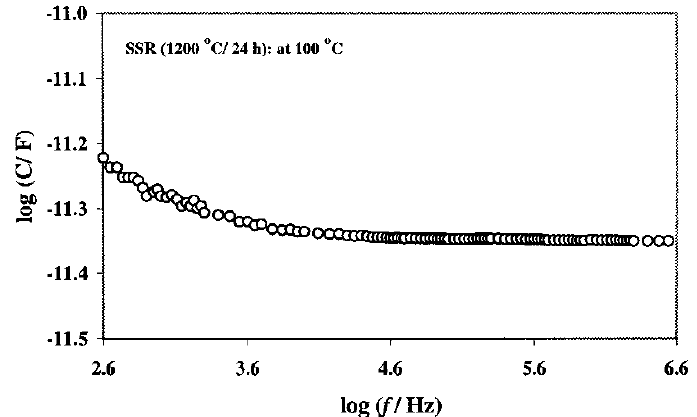
(cid:1) C with soak-time